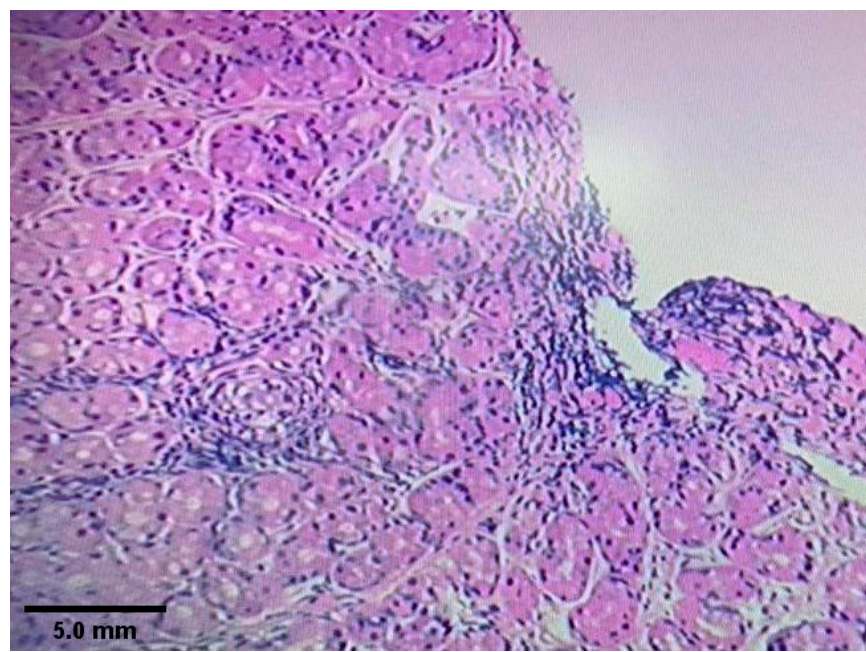
Figure 3. Gastric mucosa showing moderate chronic gastritis with no H. pylori microorganisms identified. The lamina propria is infiltrated by chronic inflammatory cell composed mostly of lymphocytes and plasma cells. There is no evidence of H. pylori microorganisms, activity, atrophy, granulomas, intestinal metaplasia, dysplasia and malignancy (Hematoxylin-eosin stain. Magnification ×10).